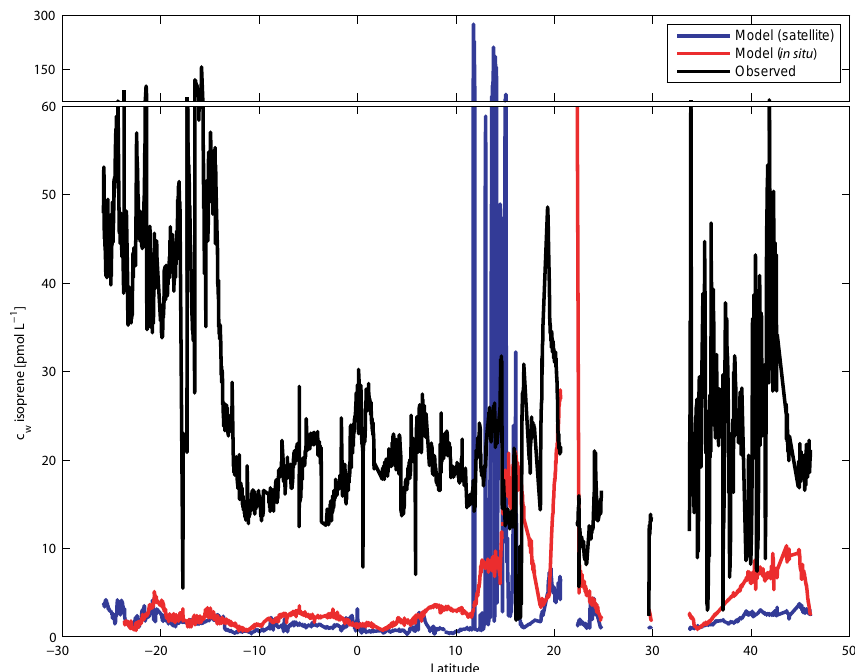
Figure 2. Comparison of observed (black) and modeled seawater isoprene concentrations for the ANT-XXV/1 cruise. Model calculations were carried out using the ISO PS05 model configuration, with monthly mean satellite data (blue) for chl a , wind speed, SST, and MLD (climatology) and in situ shipboard measurements (red).